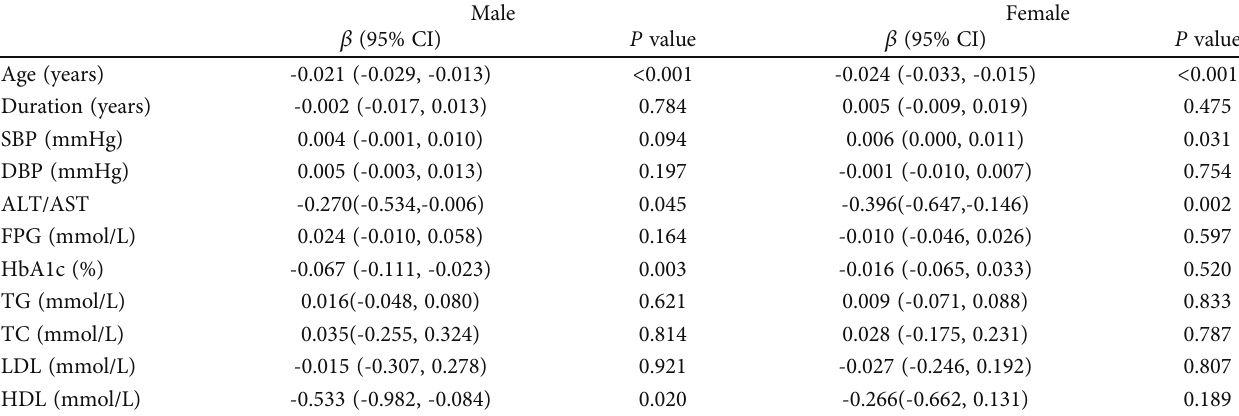
Table 3: The correlation between SMI and clinical